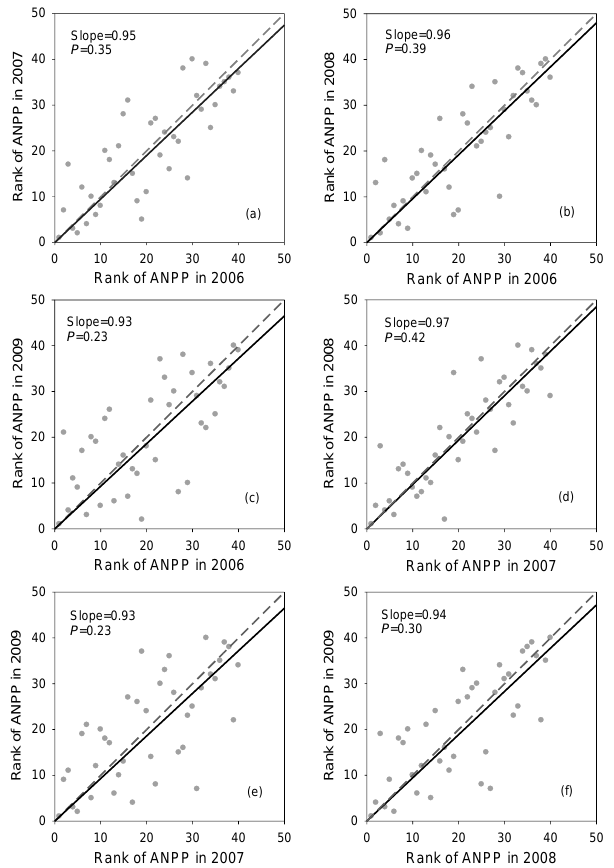
Fig. 3. The rank regression between aboveground net primary pro- duction (ANPP) for each pair of years from 2006–2009 (a–f) . The slopes of the regression lines are given, and none differ significantly from